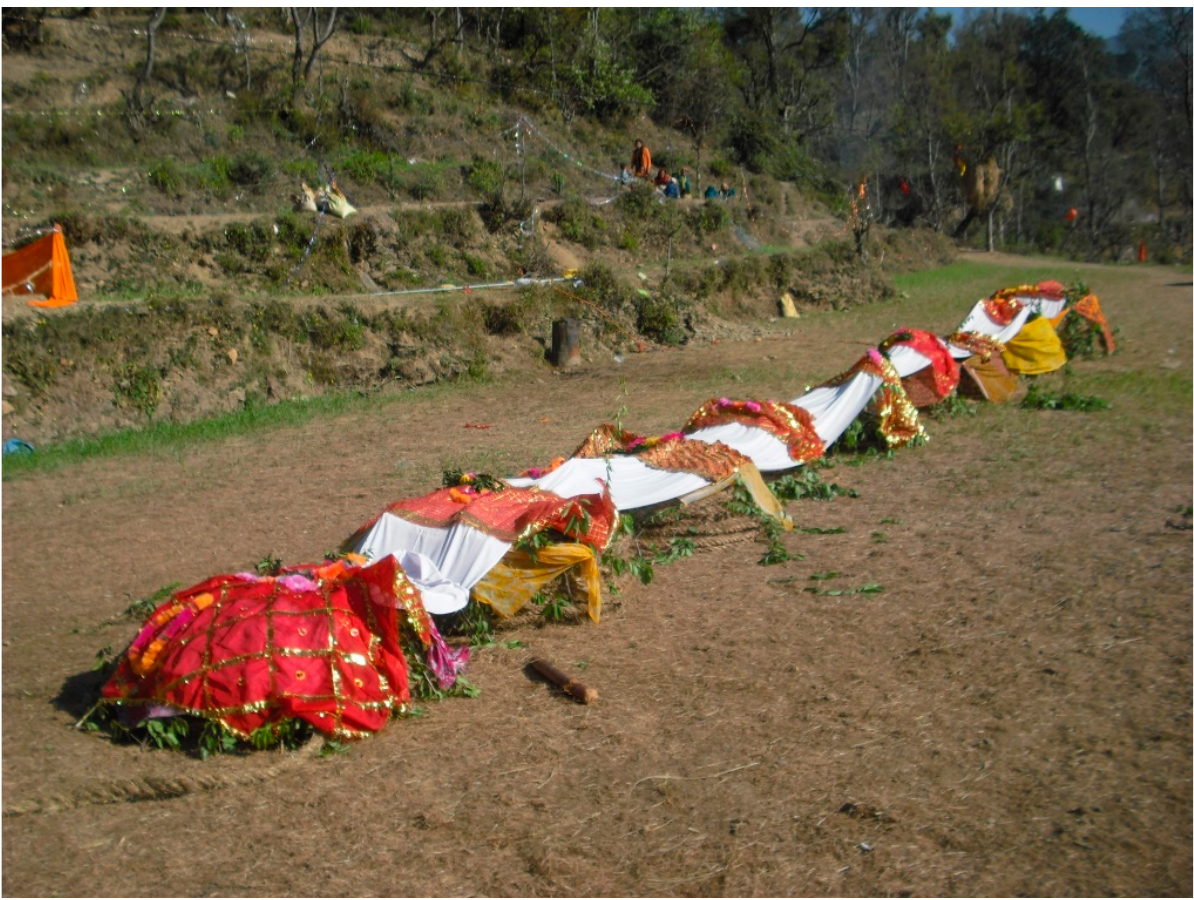
Figure 1. A rope made of babul ū grass, arranged into nine heaps, represents the nine Nai ṇ ī s, the serpent sisters of Pindar valley (image by the author, March 2011).